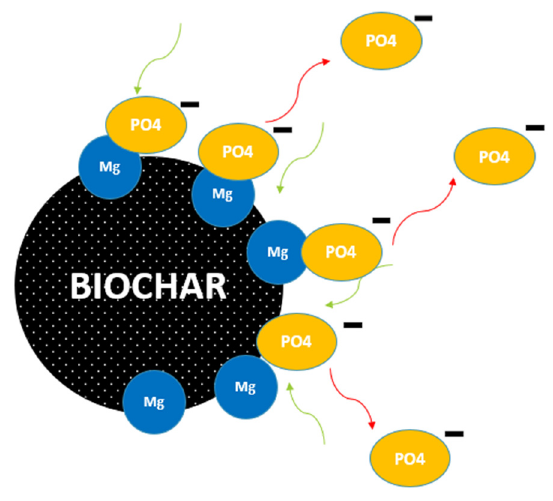
Figure 9. Overshooting phenomena of Mg-biochar.